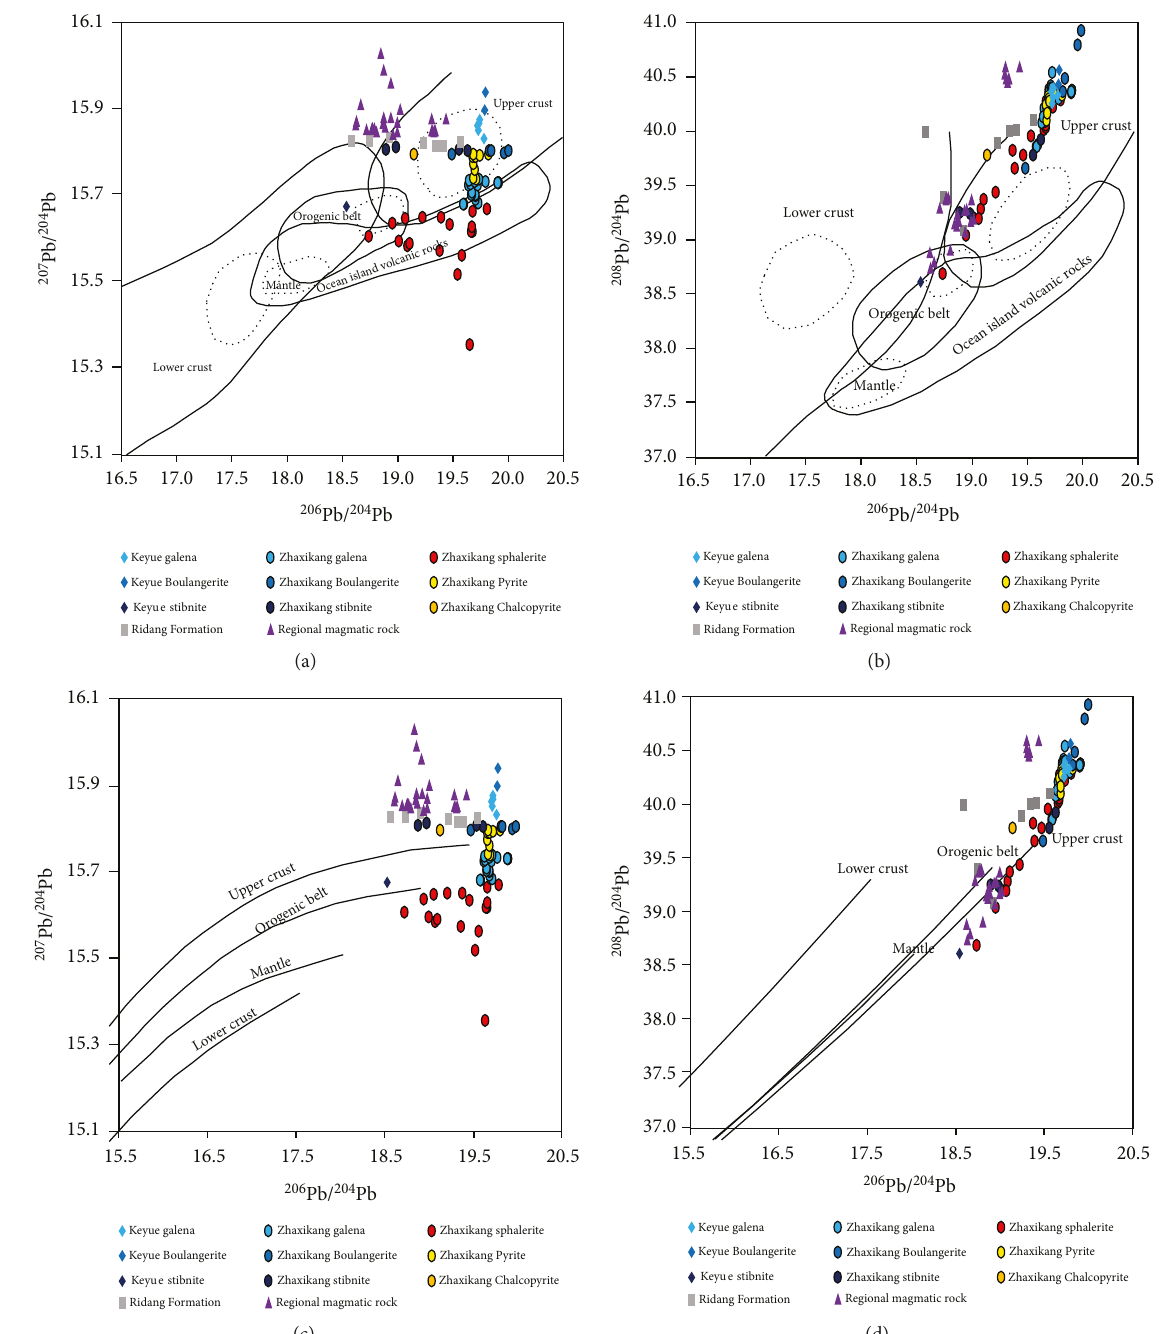
Figure 17: Diagrams of 207 Pb/ 204 Pb versus 206 Pb/ 204 Pb and 208 Pb/ 204 Pb versus 206 Pb/ 204 Pb showing the Pb isotopic compositions of sul fi de minerals from the Keyue and Zhaxikang Sb – Pb – Zn – Ag deposits; reference evolution curves of Lower Crust, Upper Crust, Mantle, Orogenic Belt, and Ocean Island Volcanic Rocks are also displayed (modi fi ed from Zartman and Doe [79]). (a) 207 Pb/ 204 Pb versus 206 Pb/ 204 Pb tectonic setting discrimination diagram; (b) 208 Pb/ 204 Pb versus 206 Pb/ 204 Pb tectonic setting discrimination diagram; (c) 207 Pb/ 204 Pb versus 206 Pb/ 204 Pb growth curve; (d) 208 Pb/ 204 Pb versus 206 Pb/ 204 Pb growth